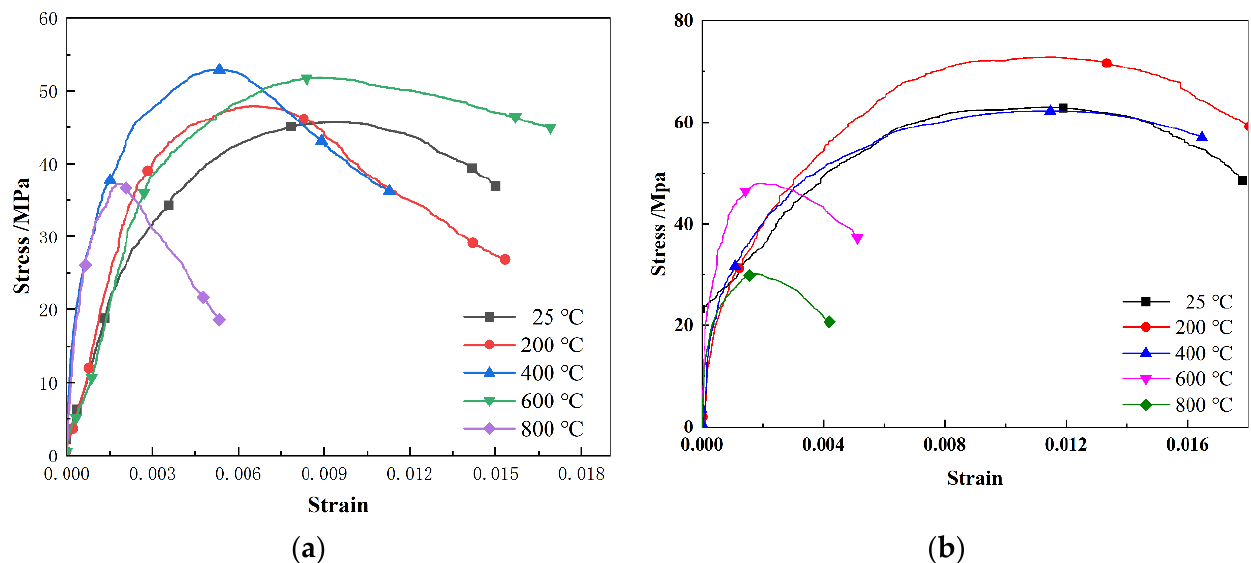
Figure 9. Dynamic stress–strain curve for a confining pressure of 1.5 MPa. ( a ) Impact velocity = 5.3 m/s; ( b ) impact velocity = 8.6 m/s.